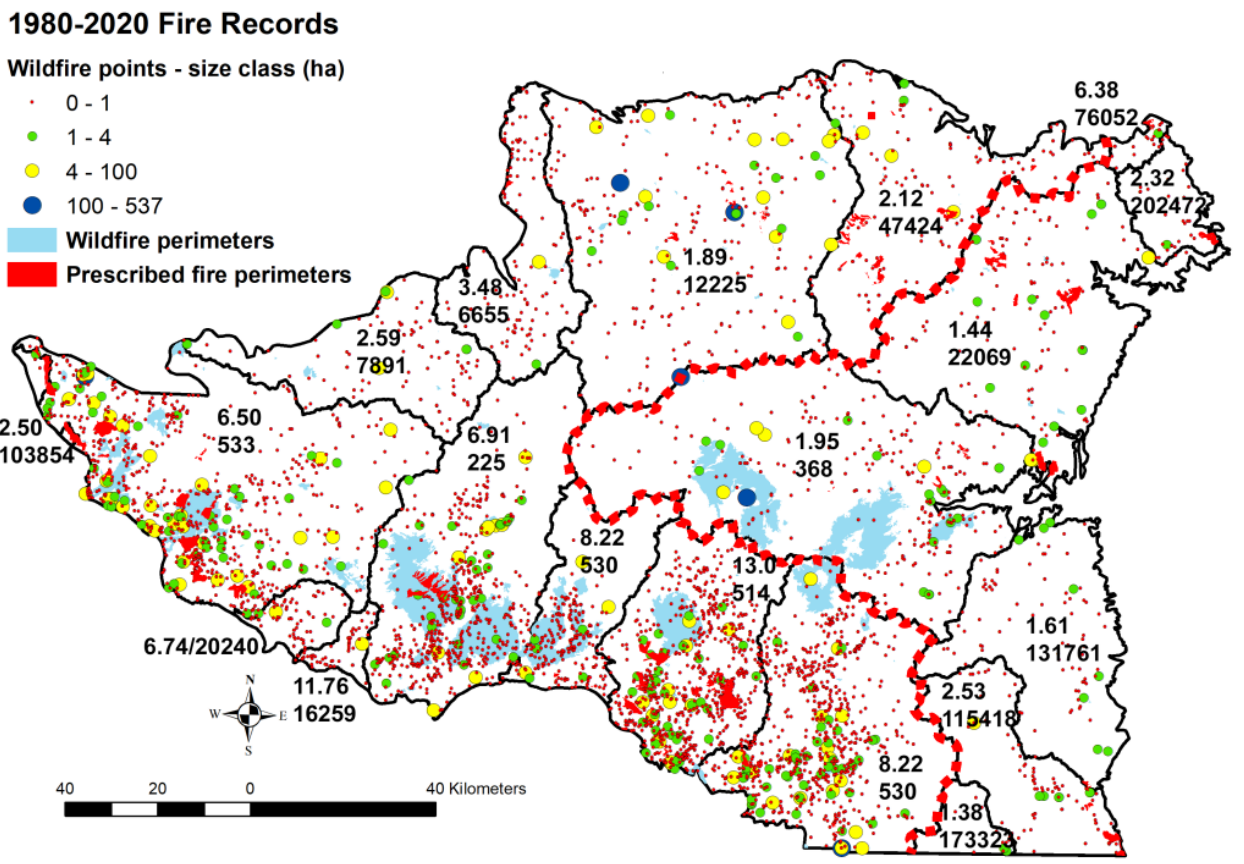
Figure 2. Wildfire perimeters and points, and prescribed-fire perimeters, for 1980 – 2020, showing the 18 watersheds and the Continental Divide (dashed red line). Numbers shown for each watershed are the fire density for the 41-year period (No. fires per year per 100,000 ha) on top and the fire rotation (years) on the bottom.